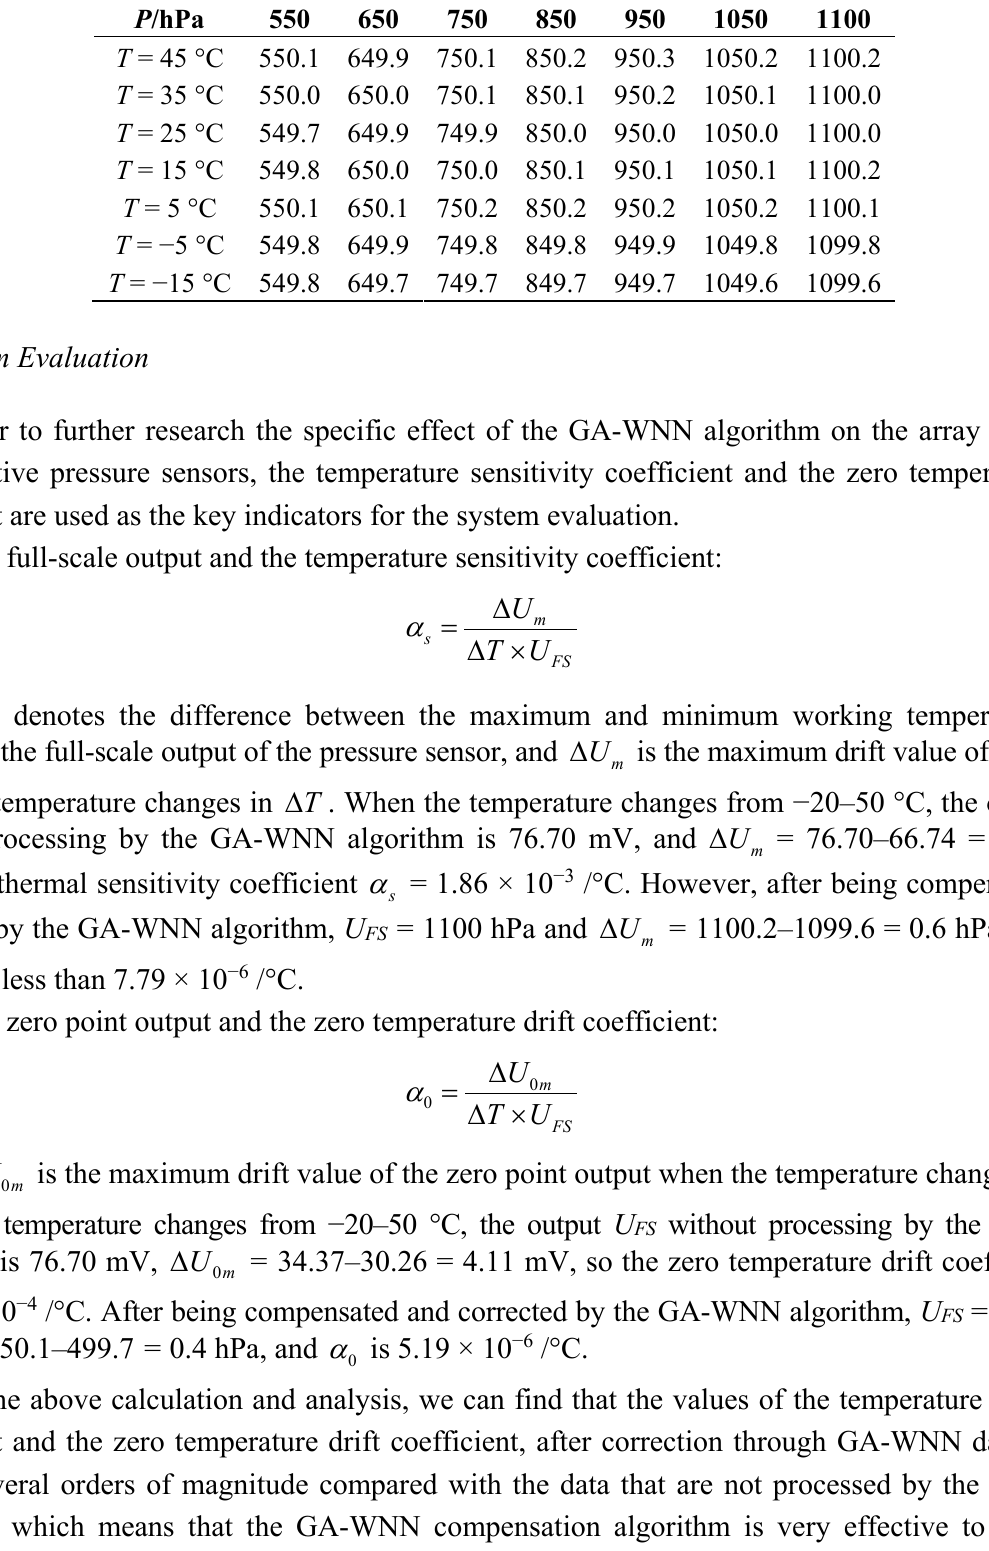
Table 2. When the test pressure is 550 hPa, 650 hPa, 750 hPa, 850 hPa, 950 hPa, 1050 hPa, 1100 hPa, the actual measurement pressures of MEMS-array pressure transmitter at 45 °C, 35 °C, 25 °C, 15 °C, 5 °C, − 5 °C and − 15 °C. P